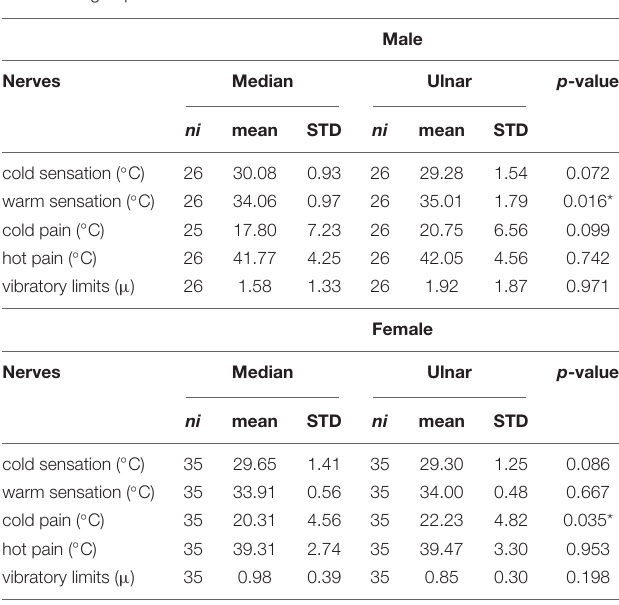
TABLE 4 | Mean QST parameters in the median and ulnar nerves in the male and female groups.